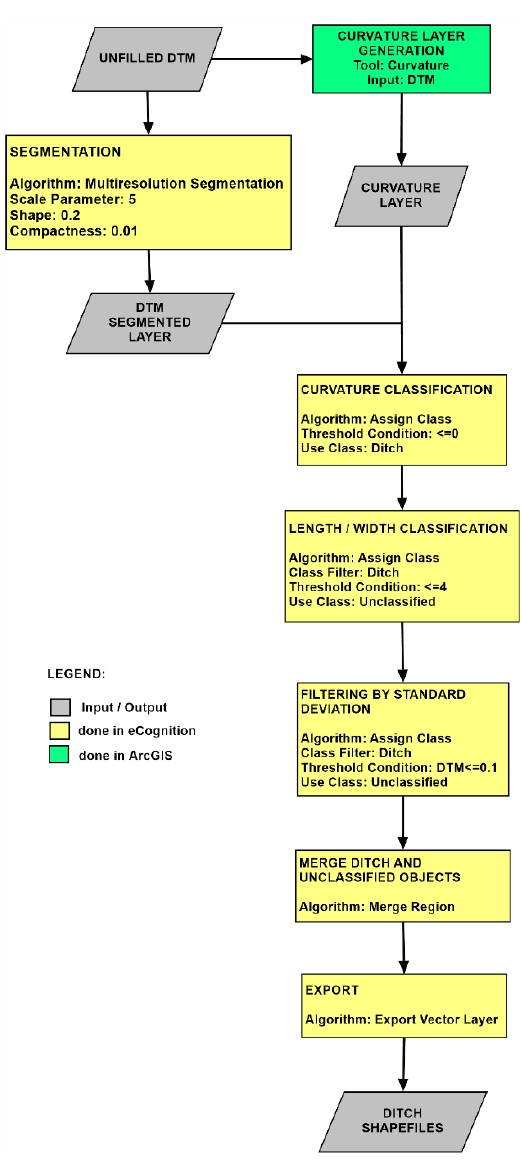
Figure 9. Flow diagram for extracting agricultural ditches using LiDAR